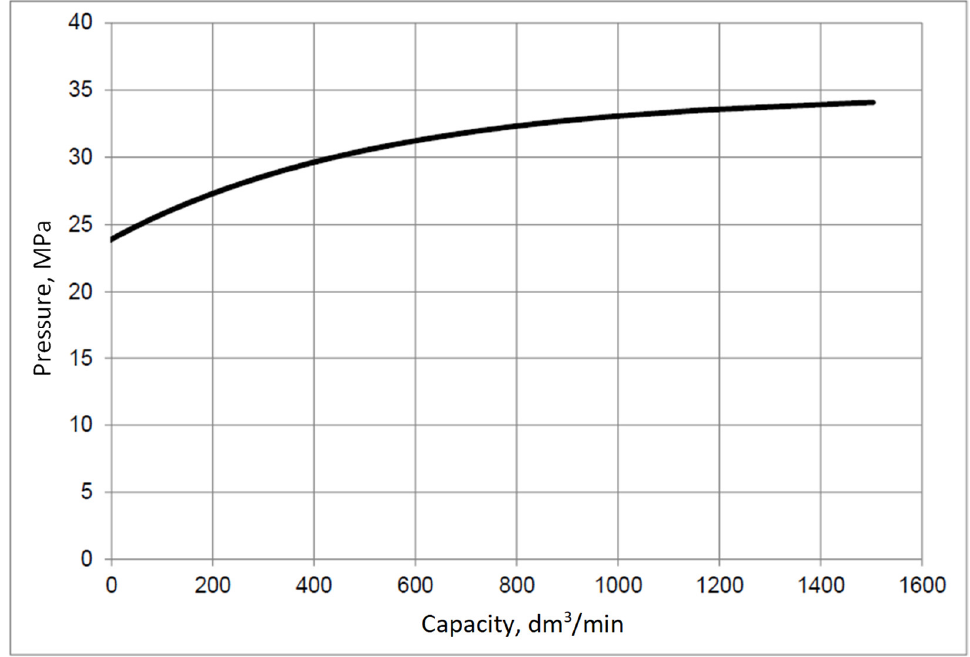
Figure 8. Valve flow characteristics determined using the presented methodology.